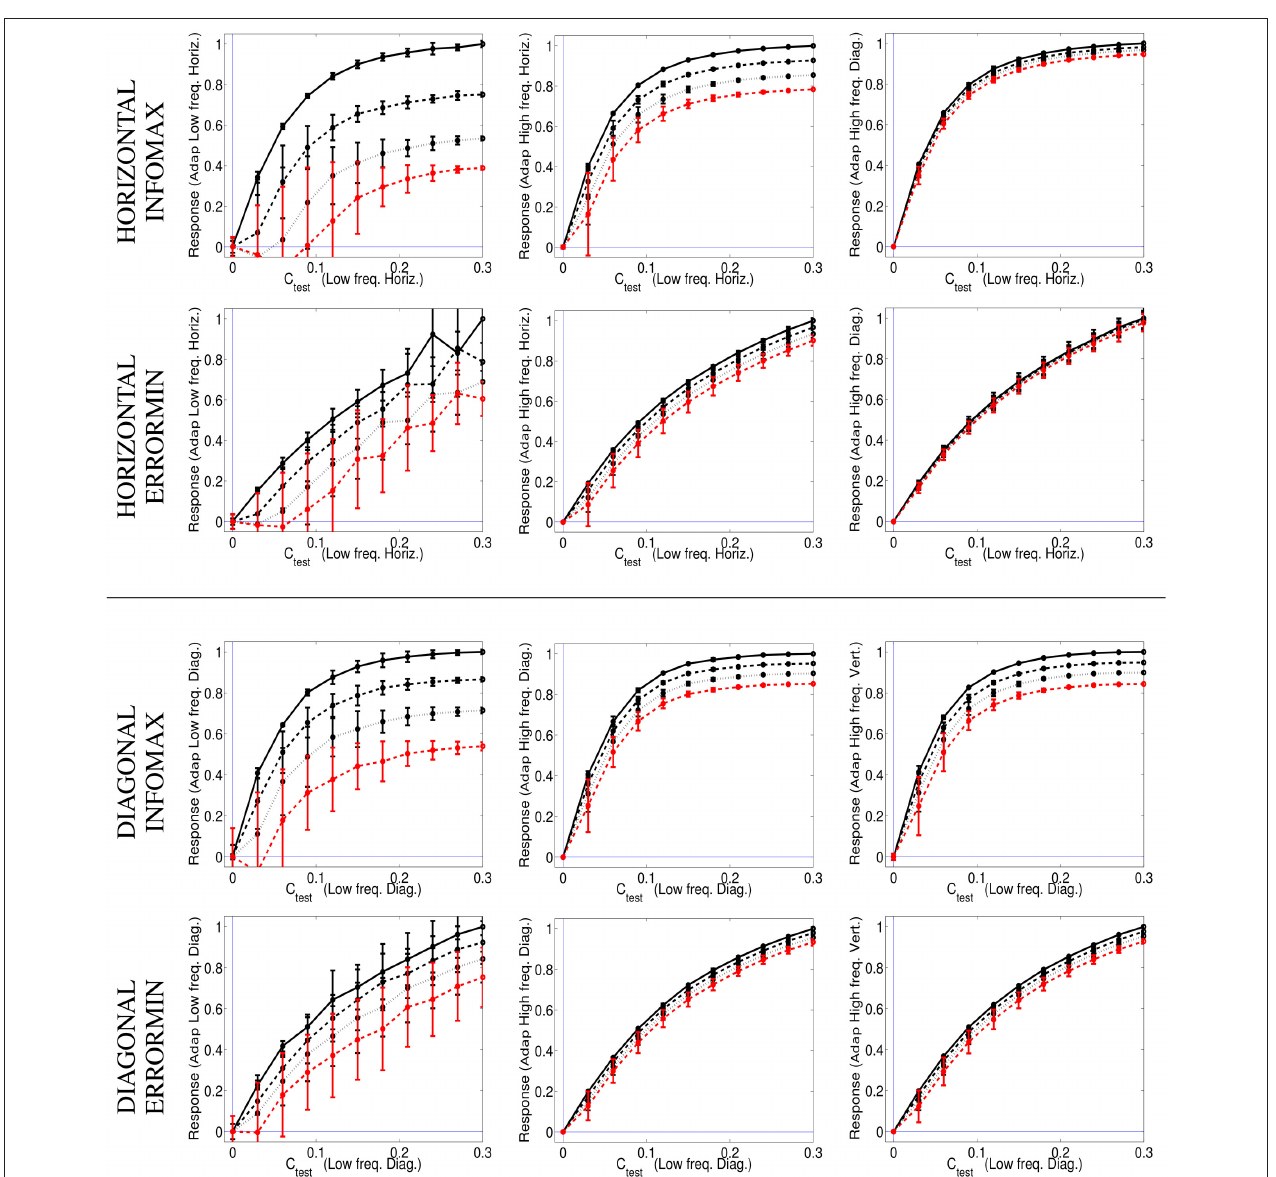
FIGURE 8 | Responses of SPCA texture sensors in environments where other textures are present. Top (1st and 2nd rows) responses of the SPCA low frequency horizontal sensor. These nonlinear responses correspond to the training data in the top row of Figure 7 . Bottom (3rd and 4th rows) responses of the SPCA low frequency diagonal sensor. These nonlinear responses correspond to the training data in the bottom row of Figure 7 . In each panel, two design strategies were used (infomax, top, and error minimization, bottom). As discussed in Figures 6 , 7 , the frequency distance between test and adaptor increases from left to right. Responses are the average of the realizations of equivalent stimulation conditions. Since stimulation (and adaptation) with positive or negative contrast is equivalent (note the symmetry of the scatter plots), the responses shown are the average over these equivalent observation conditions. Different line styles correspond to progressively stronger contrast of the adapting environment (as in the scatter plots in Figure 7